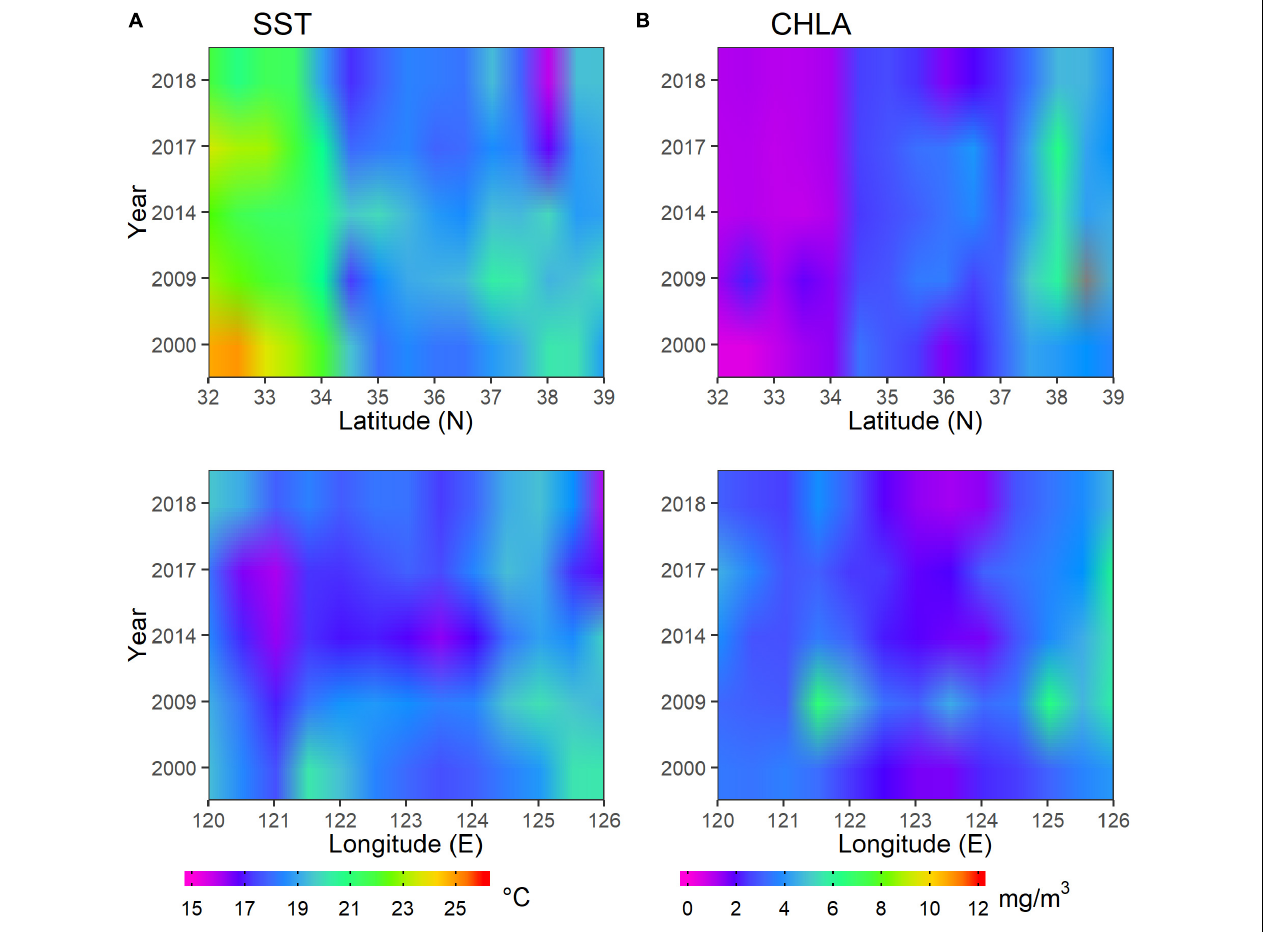
FIGURE 6 | Spatiotemporal distribution of monthly oceanographic variables in October of 2000, 2009, 2014, 2017, and 2018 for (A) sea surface temperature (SST) and (B) chlorophyll-a concentration